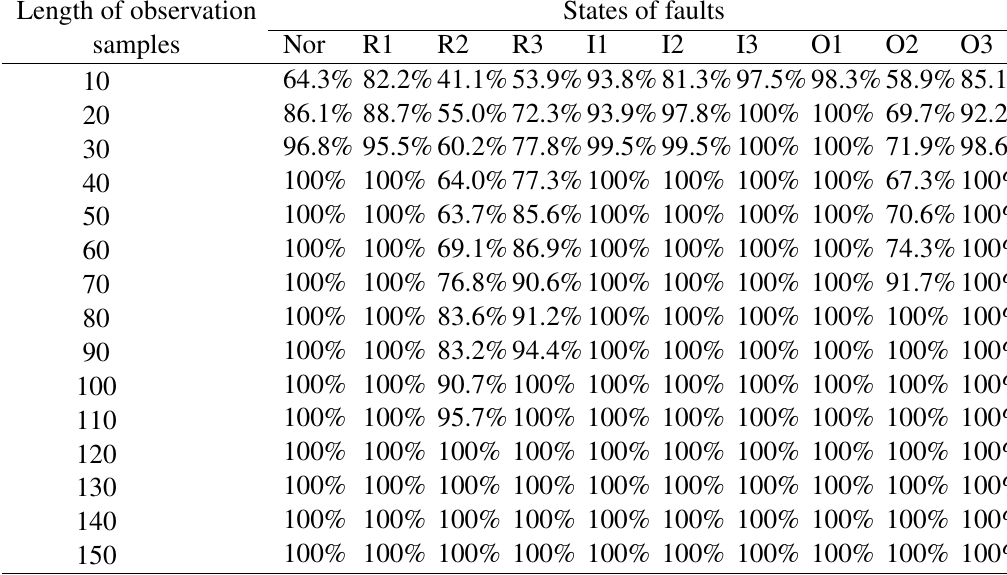
Table 5 Statistics of test results of various fault states for different sample